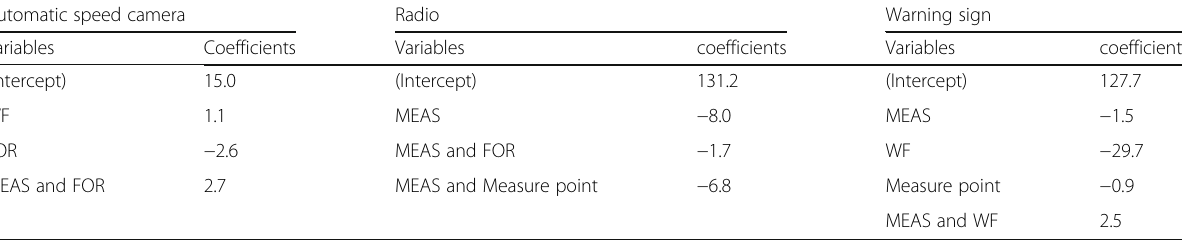
Table 2 Results of MARS analysis showing effects on vehicle speed of automatic selection of influential independent variables Automatic speed